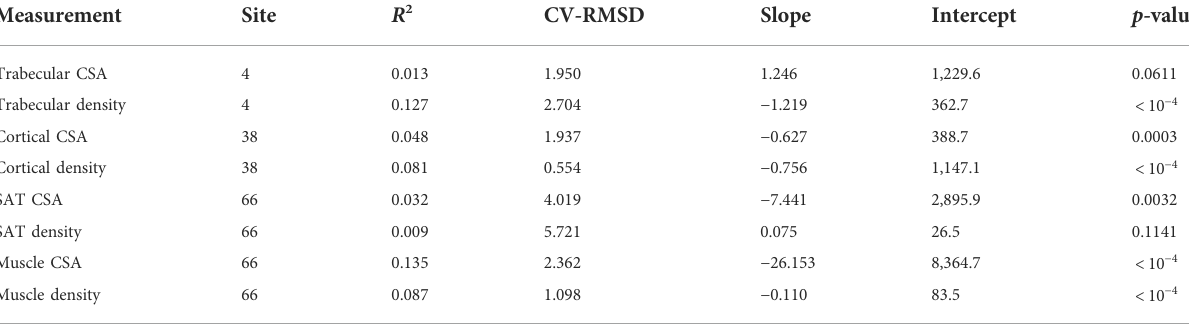
TABLE 13 Statistical measures of the relationships between tissue properties and age for males.